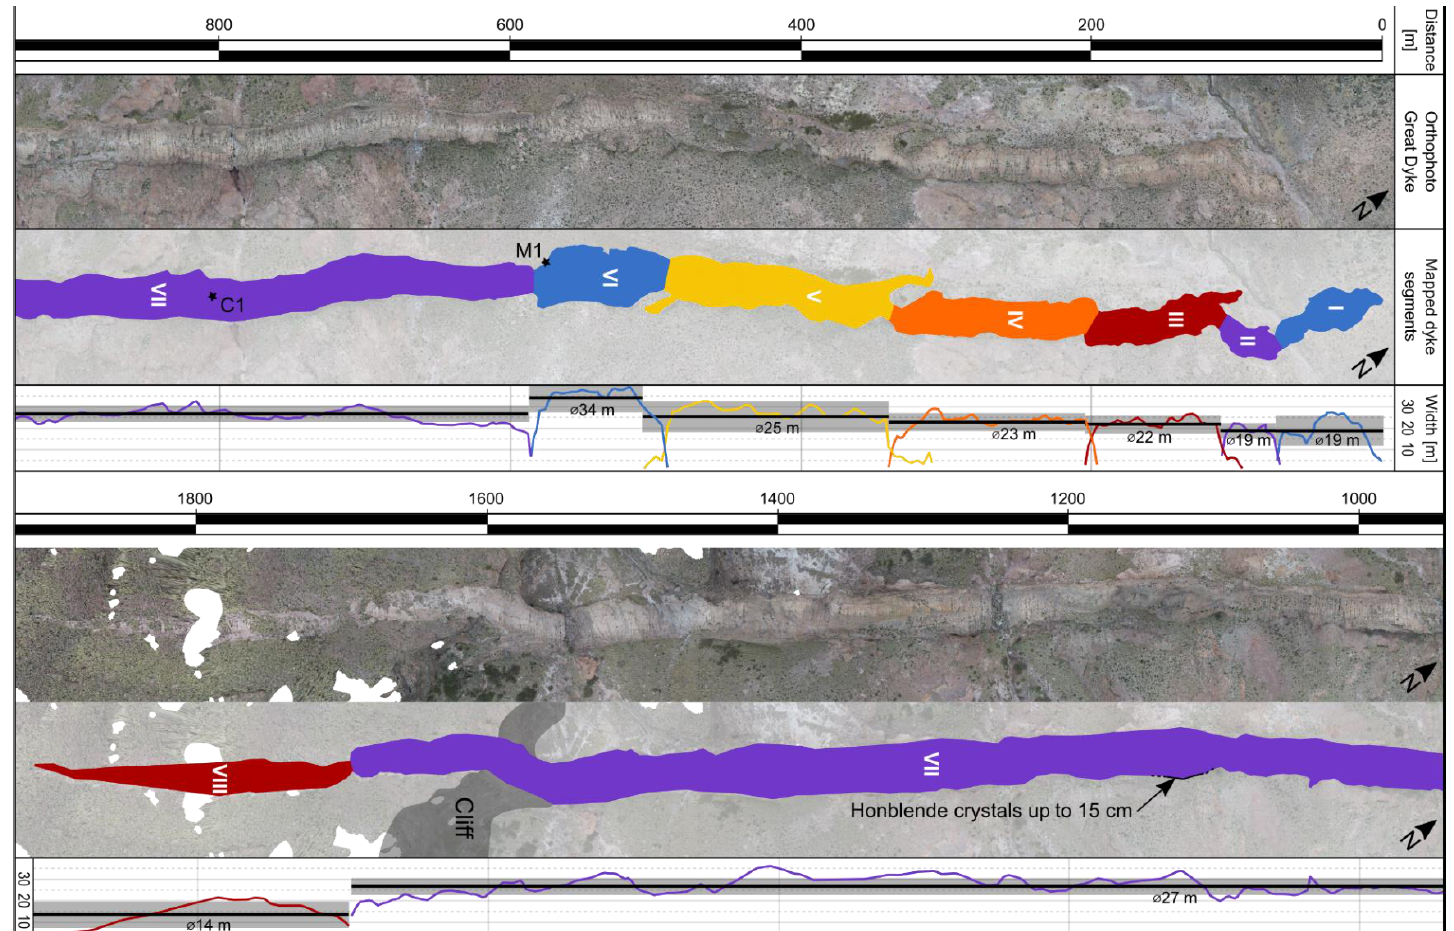
Figure 4. Great Dyke overview. (left column) Orthophoto with a 10 cm resolution. (middle column) Interpretation of the orthophoto showing dyke segments ( I-VIII ) Different colours are solely for visualisation purposes and do not reflect any specific properties of the segments; Vertical cliff c. 200 m (dark gray, see Figure 5A,B); Black stars mark the sample locations for whole rock geochemistry samples C1 and M1 (Figure A1). (right column) Thickness plot along the dyke length; solid black line and corresponding value describe the average thickness; Standard deviation (grey zone); Thickness measurements with 5 m spacing (coloured lines).